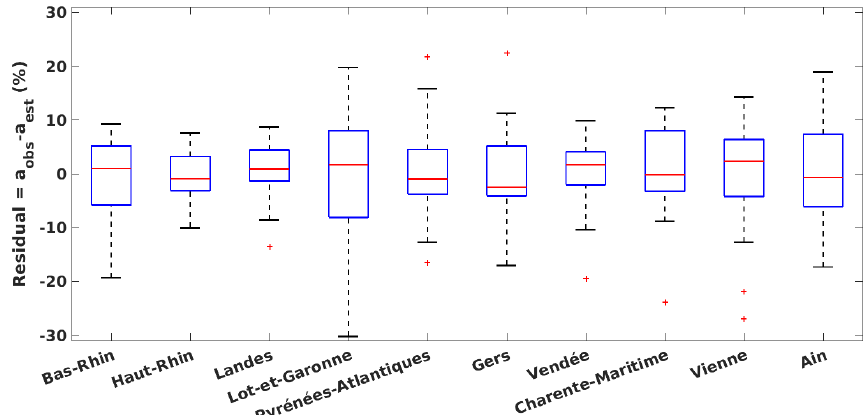
Figure 12. Boxplots of residuals (the difference between the observed and estimated yield anomalies) for 10 major grain-maize-producing departments: red horizontal bars are medians, boxes show the 25th–75th percentiles, error bars depict the minimum and maximum values, and red + signs are suspected outliers.